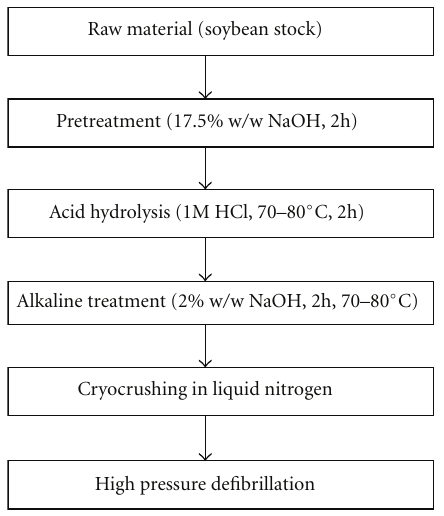
Figure 2: Isolation of nanofibers by chemomechanical treatment